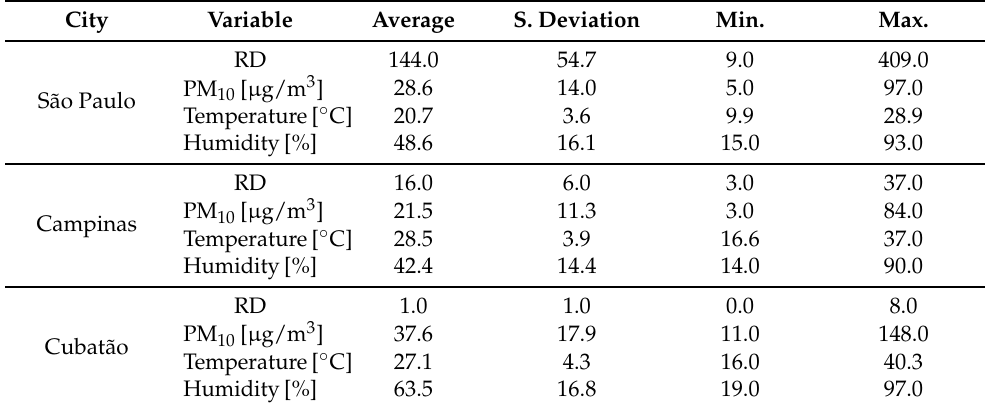
Table 1. Descriptive statistics for the variables.